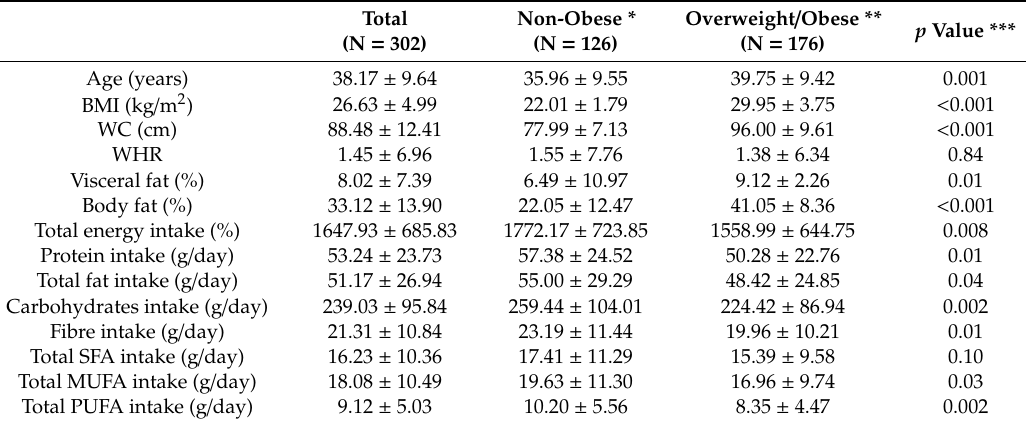
Table 1. Characteristics of the study